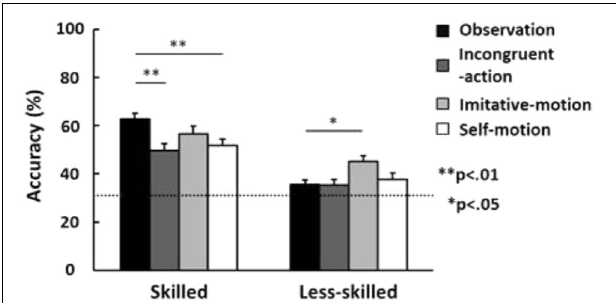
FIGURE 2 | Percentage of correct responses in each condition (observation, incongruent-action, imitative-motion, and self-motion) for the skilled and less-skilled groups. The horizontal dashed line indicates the chance level. Vertical error bars show standard errors. ∗ p < 0.05, ∗∗ p <